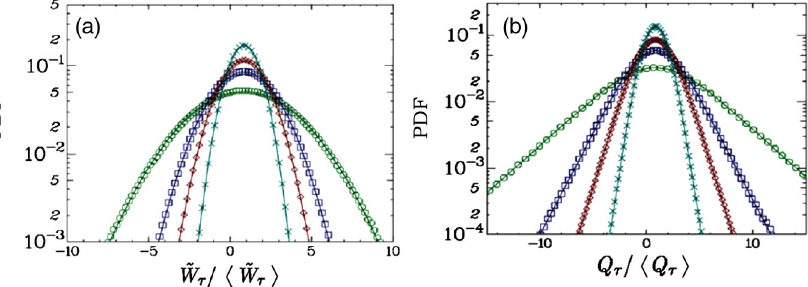
~ W ¼ 7 ( ∘ ), n ¼ 15 ( □ ), n ¼ 25 ( ⋄ ), and n ¼ 50 (×). The FIG. 2. Sinusoidal forcing. (a) Pdf of τ . (b) PDF of Q τ for various n : n continuous lines are not fits but are analytical predictions obtained from the Langevin dynamics, as discussed in Sec. III